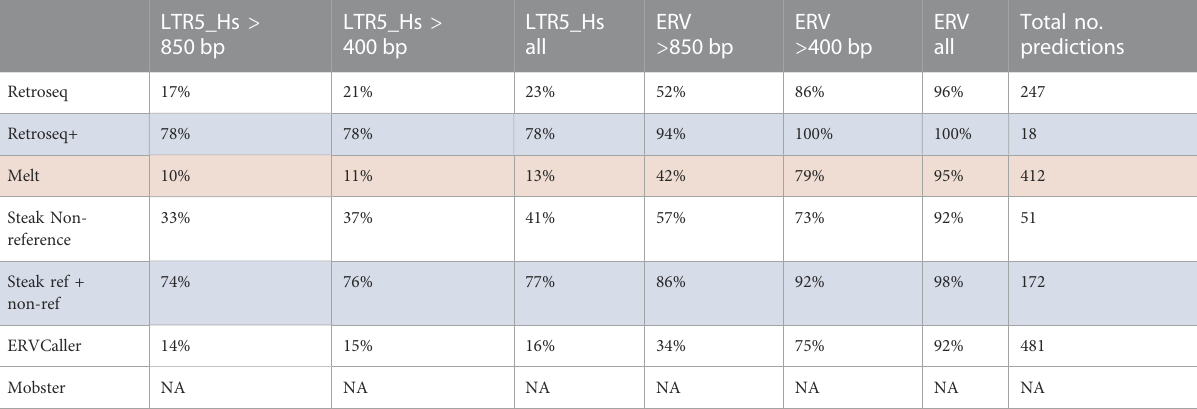
TABLE 4 This table shows the proportion of results predicted by each tool in the short-read samples, that are positive for a HERV sequence in the associated long-read data. Each column shows the proportion of results that were positive for HERV-K (LTR5_Hs, the targeted HERV subgroup) or a general HERV sequence in the long-read contig data. The results are strati fi ed by the length of the HERVsequence found in the long-read contig data.The Steak results are reported both including and discarding reference HERV loci. Reference HERV loci were removed for all other tools. Top performing and lowest performing tools are highlighted in blue and red respectively.